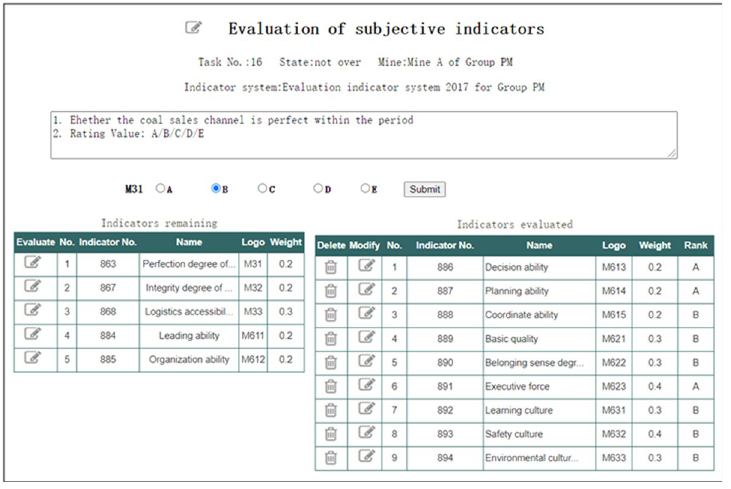
Fig 14. Evaluation of final-level subjective indicators.